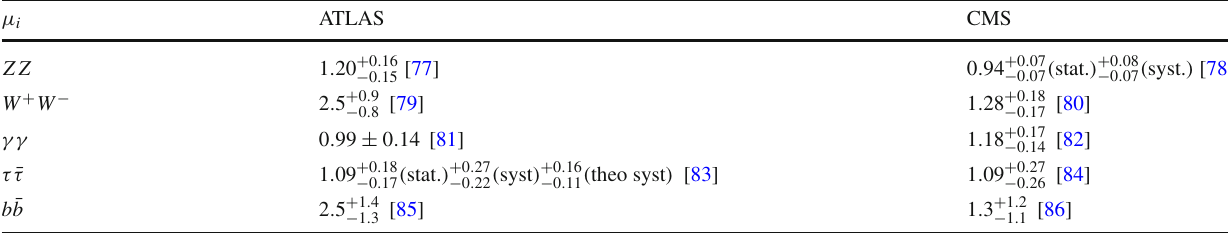
Table 1 Latest limits on the h -signal